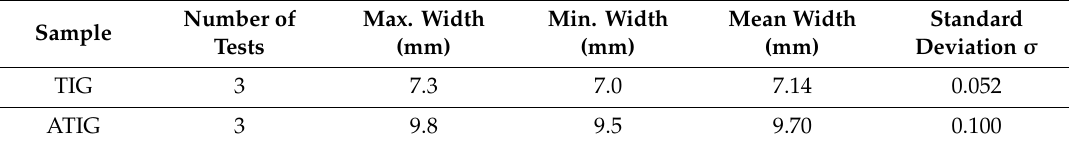
Figure 10. Widh (W) and depth (D) of welded beads of TIG ( a ) and ATIG ( b ). Table 5. Mesurments of width and standards deviation of TIG and ATIG (optimal flux).